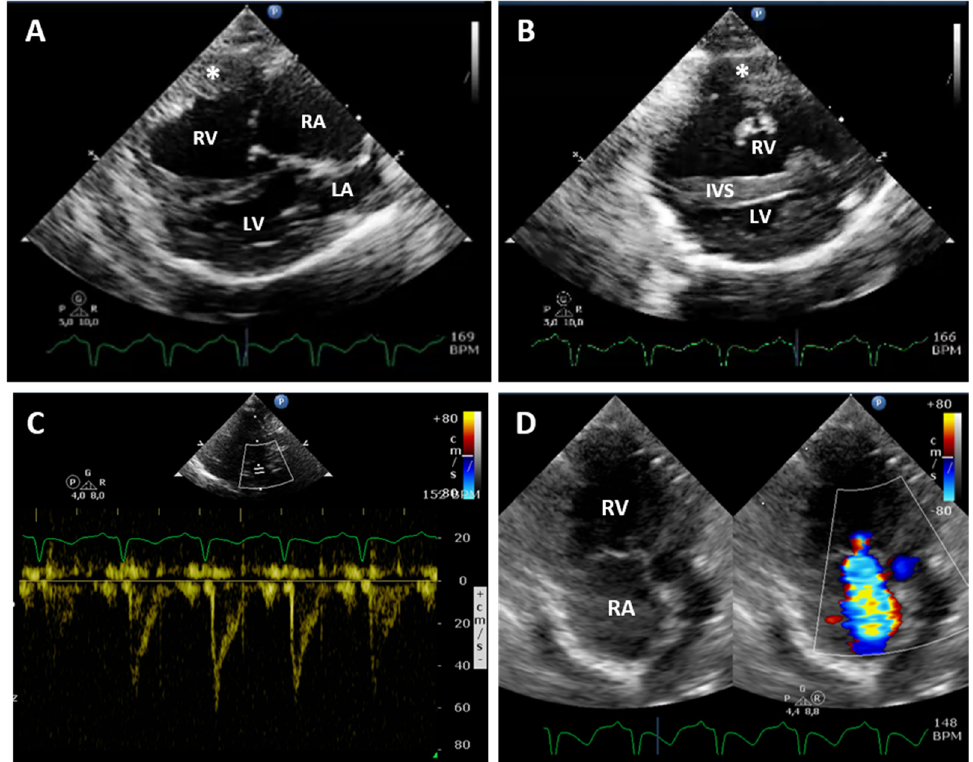
Figure 2. Echocardiography at presentation: ( A , B ) Right parasternal window long-axis 4-chamber view and short-axis view at the level of papillary muscles, respectively. Severe right atrium and ventricle dilation, right ventricle free wall hypertrophy and a reduced left ventricular diameter were evident. ( C ) Pulsed-wave Doppler tracing of the pulmonary artery systolic flow: the laminar flow profile is asymmetrical with a sharp peak, corresponding to type II pulmonary blood flow. ( D ) Left parasternal window apical view optimized for the right heart. On color flow mapping (on the right), moderate-severe tricuspid regurgitation is evident. RA, right atrium; RV, right ventricle; IVS, interventricular septum; LA, left atrium; LV, left ventricle; *, right ventricular free